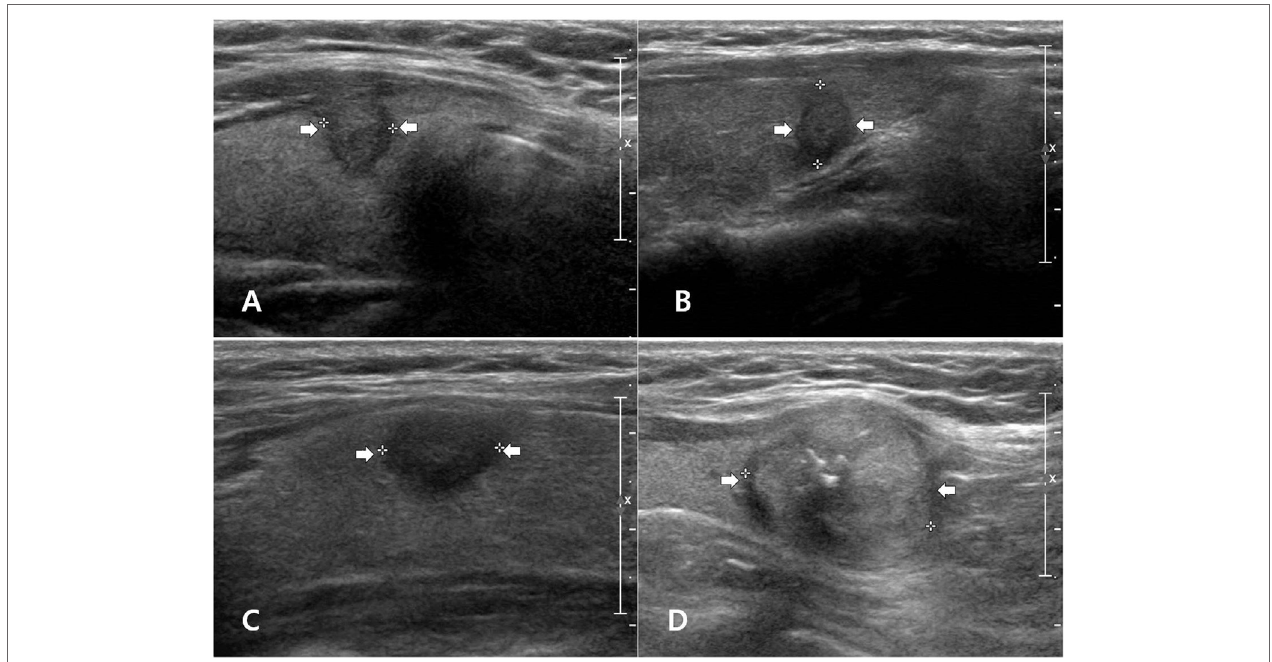
FigUre 1 | Examples of papillary thyroid carcinoma (PTC) subtypes with malignant ultrasonographic feature(s) on longitudinal gray-scale sonograms: classic PTC (a) , follicular variant (B) , tall cell variant (c) , and oncocytic variant (D)